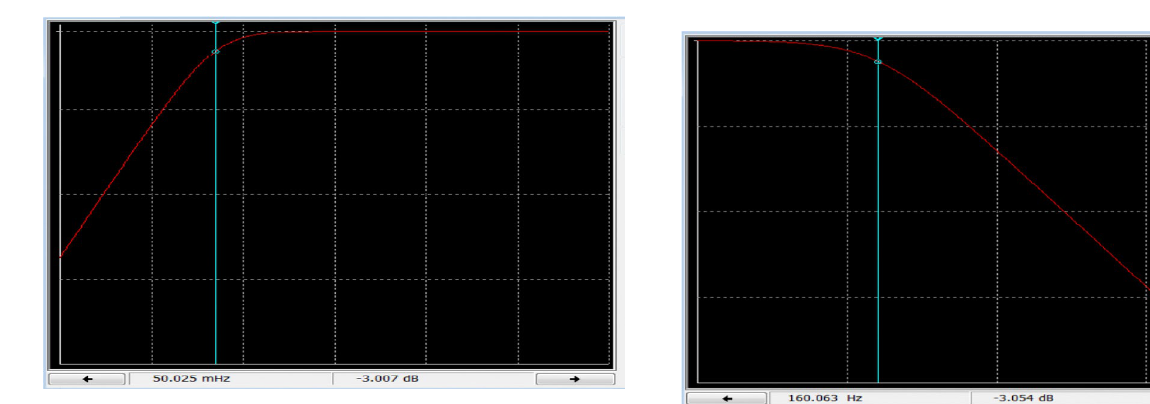
Fig. 14 ECG signal after high-pass filter